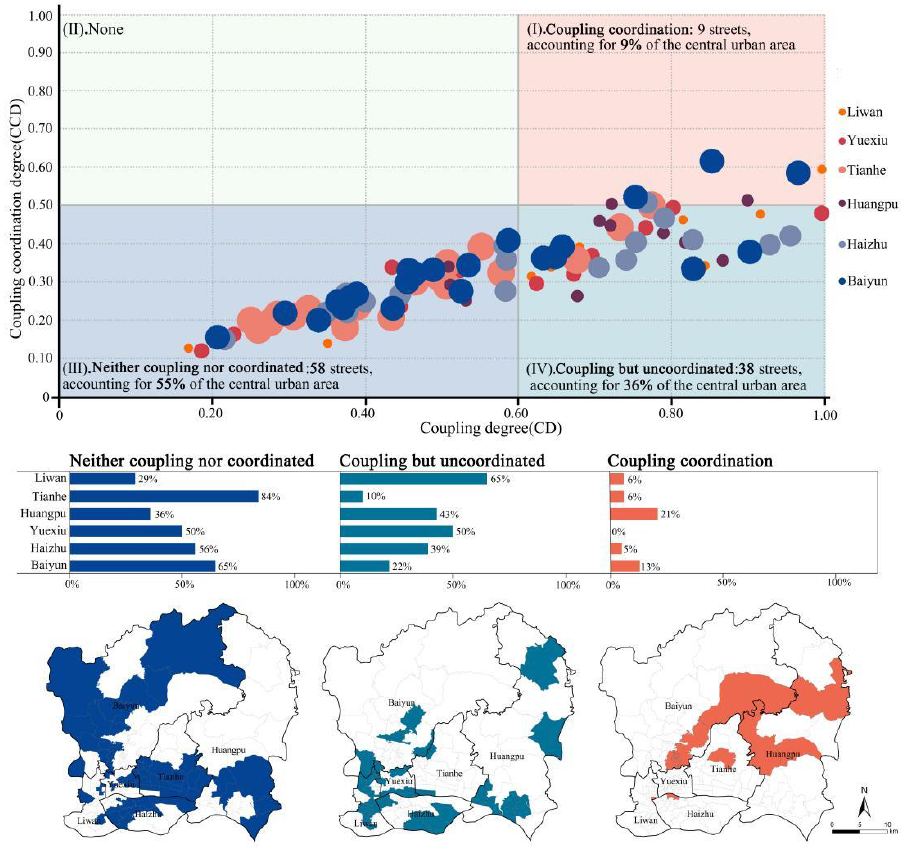
Figure 6. Quadrant analysis of CD and CCD.